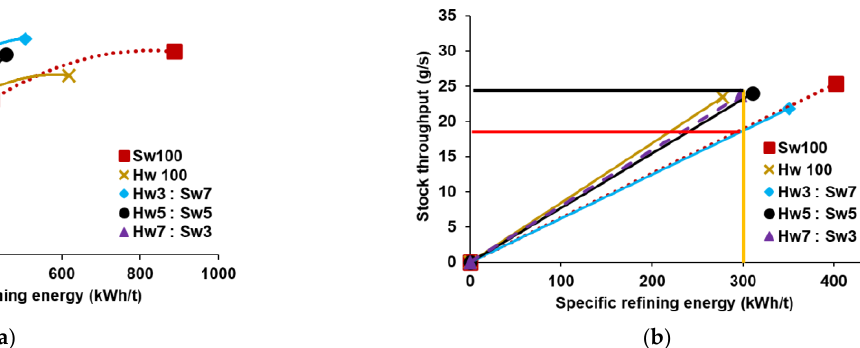
Figure 13. Effect of CEL on stock throughputs of mixed pulps: ( a ) PA55; ( b ) PB97.